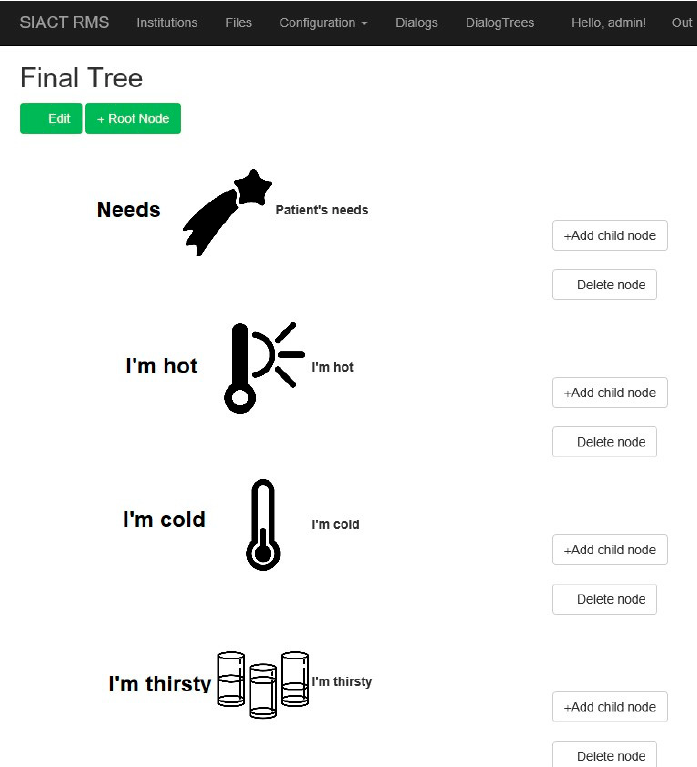
Figure 15. Building of a tree with several hierarchical levels in the Patient WEB Application.